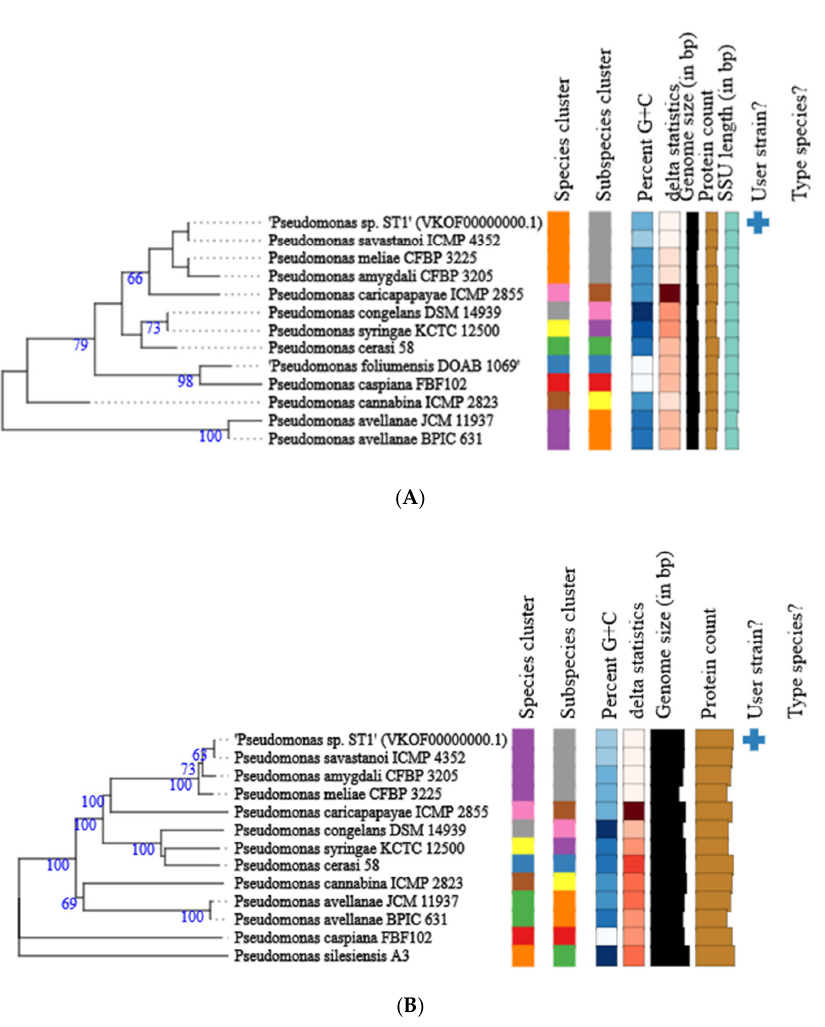
Figure 2. Phylogenetic tree of Pseudomonas ST1 strain calculated from 16S rDNA gene sequences ( A ); phylogenetic tree of Pseudomonas ST1 strain calculated from whole genome sequences ( B ). Different colors within each column indicate different minimum, maximum and intermediate values; and + represents user strain.